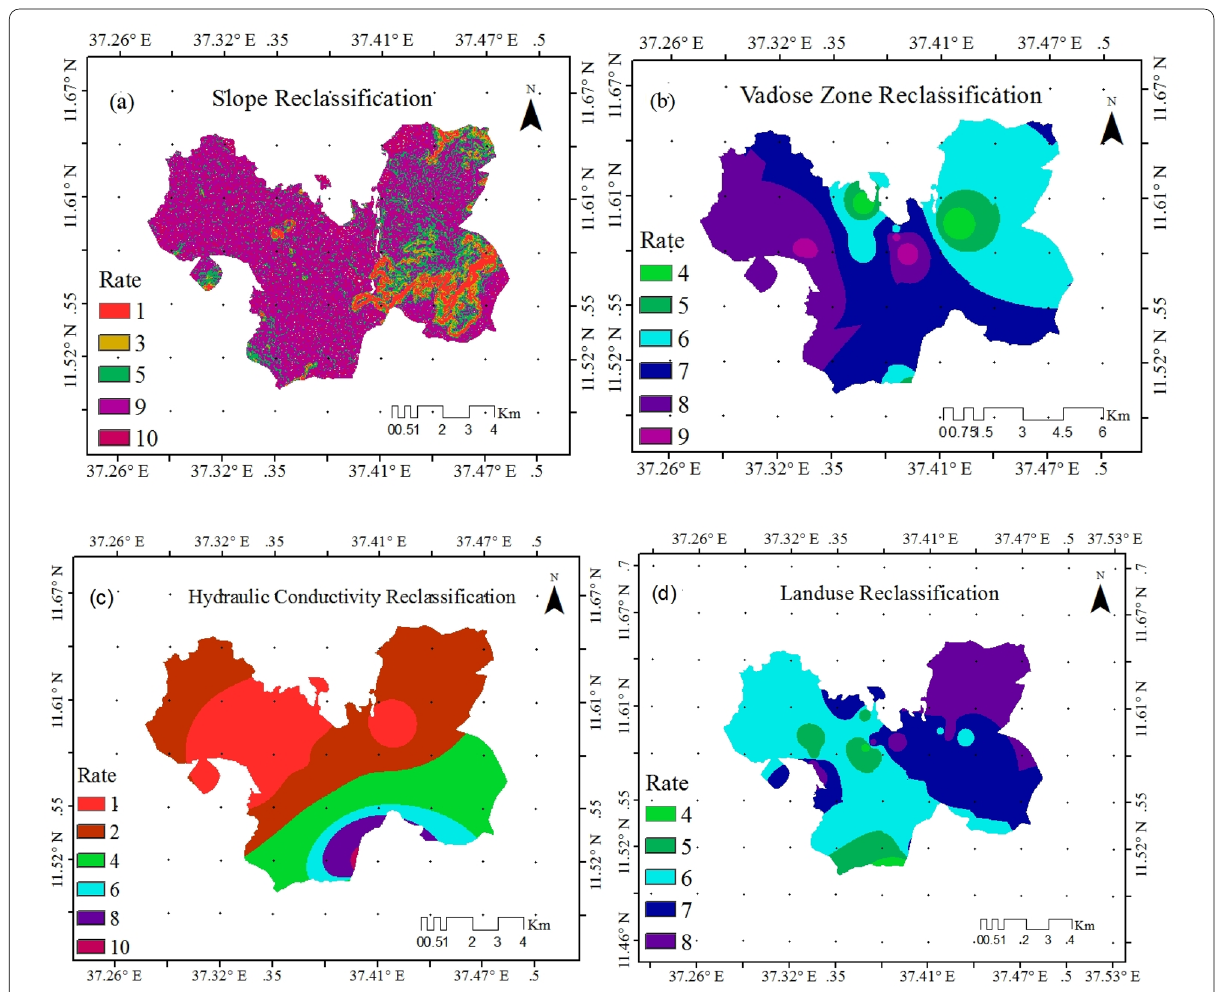
Fig. 3 The rate and spatial distribution of vulnerability parameters: a slope, b Impact of the vadose zone, c Hydraulic conductivity, d Land use of the study